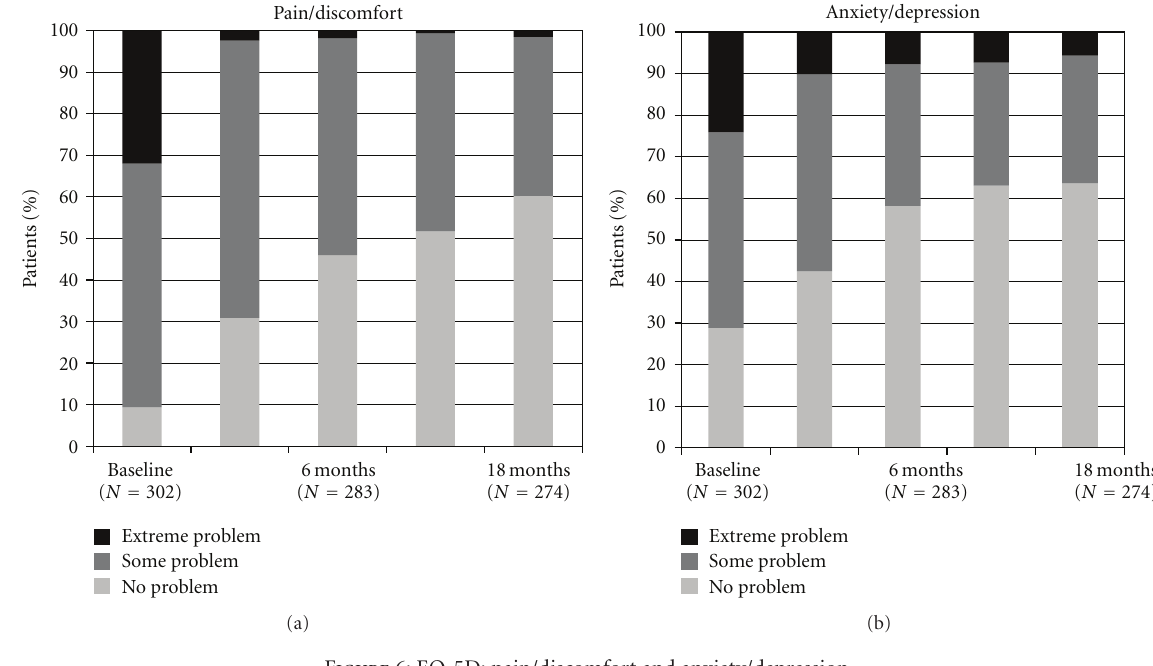
Figure 6: EQ-5D: pain/discomfort and anxiety/depression. Table 3: % of patients experiencing improvements in frequency and severity of back pain and limitation of activities. Improvement (% of patients)